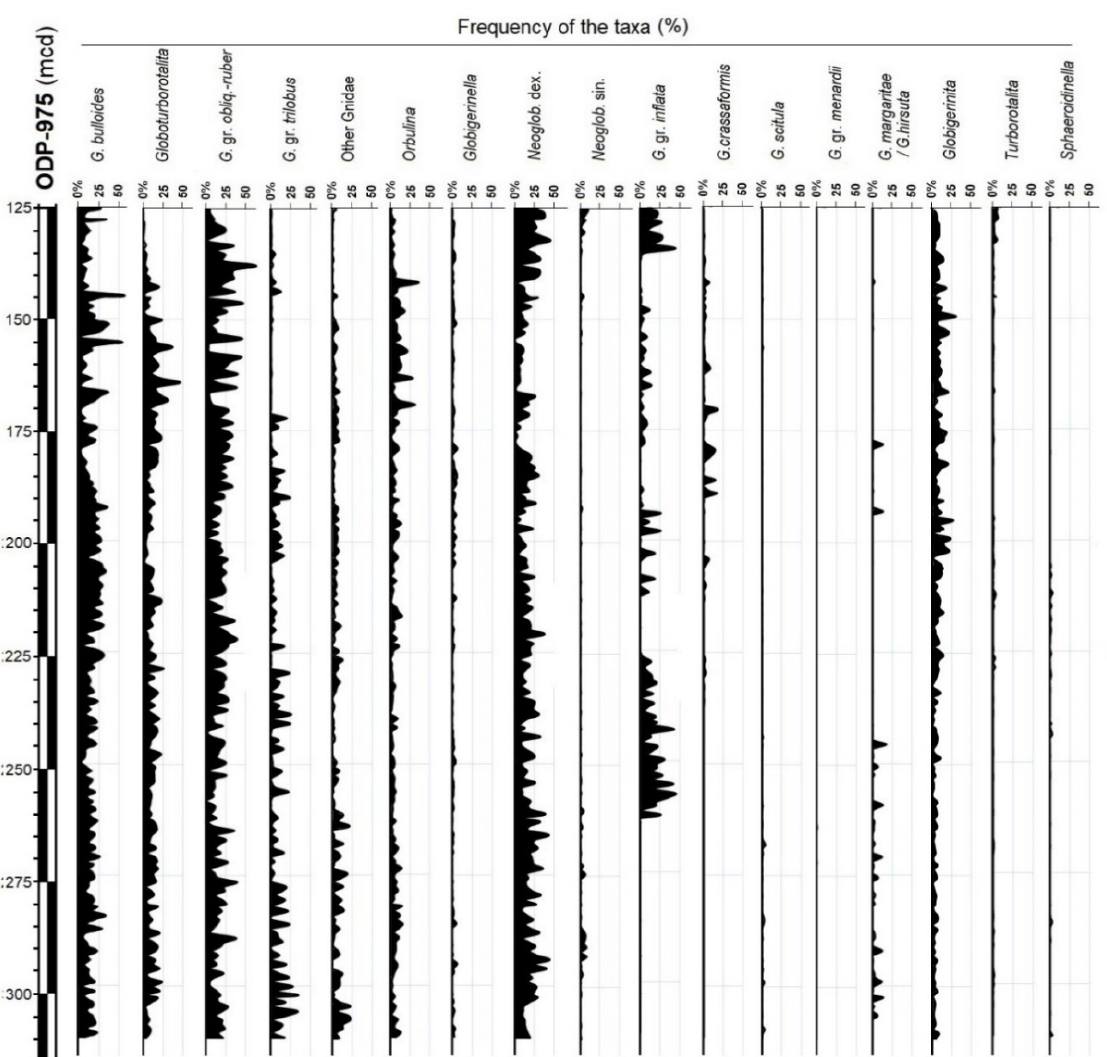
Figure 2. Quantitative composition of the assemblages of planktonic foraminifera through Pliocene– Gelasian sediments drilled by the ODP at the site 975. Other Globigerinidae (Gnidae) include: B. digitata , G. calida and G. falconensis ; G. gr. oblq.-ruber includes: G. conglobatus , G. extremus , G. obliquus , G. elongatus and G. ruber ; G . gr. trilobus includes: G. trilobus and G. sacculifer ; G. gr. inflata includes: G. inflata , G. bononiensis and G. puncticulata ; Sphaeroidinella includes Sphaeroidinellopsis species.